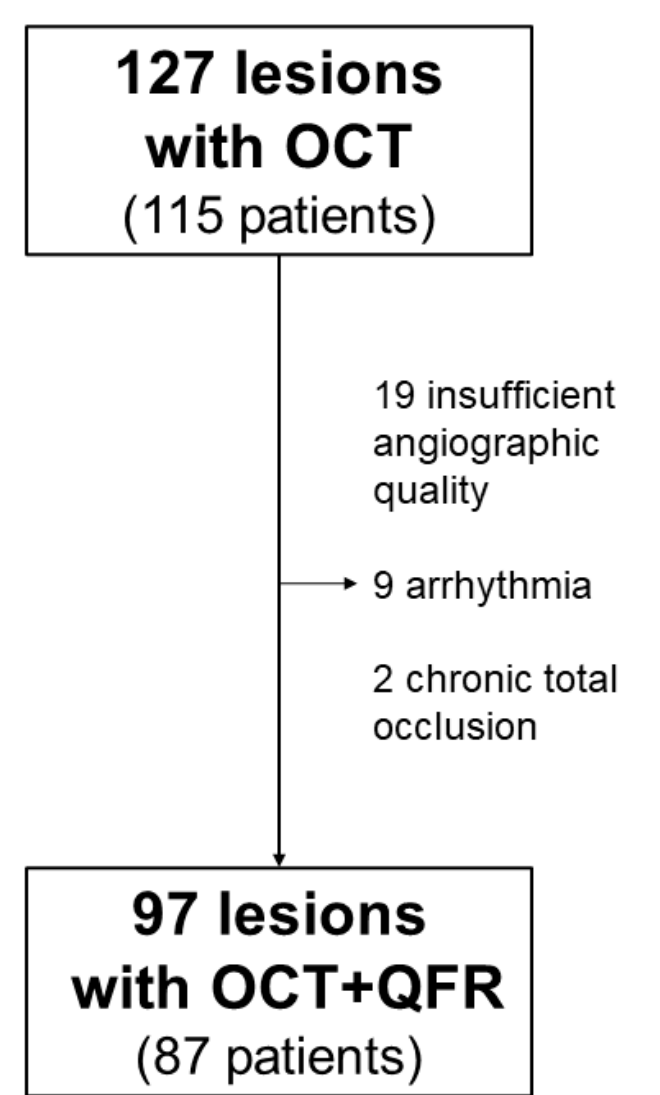
Figure 1. Flowchart depicting study